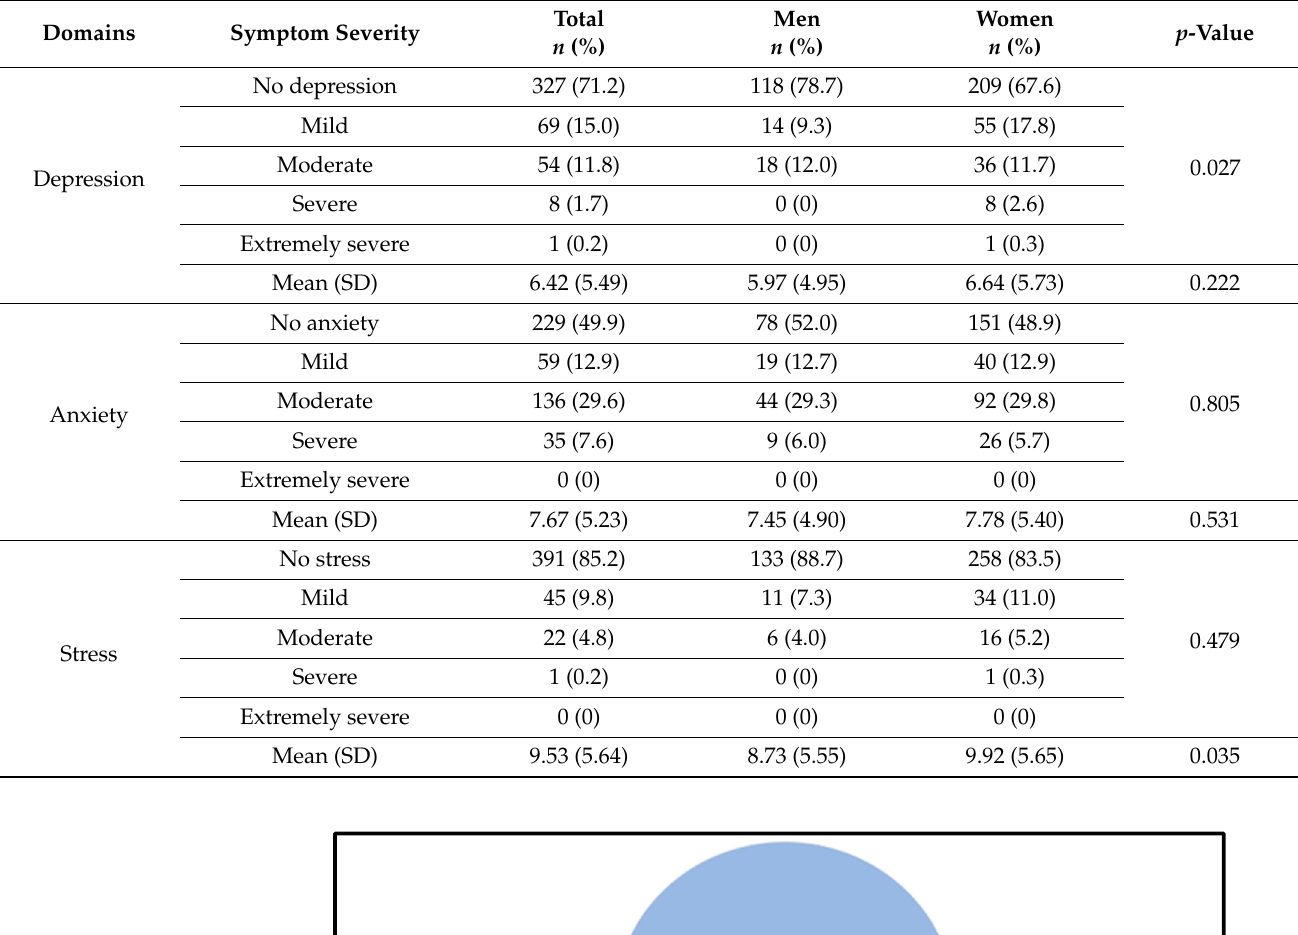
Table 2. Total scores from the DASS-21 questionnaire and by gender ( n = 459). Domains